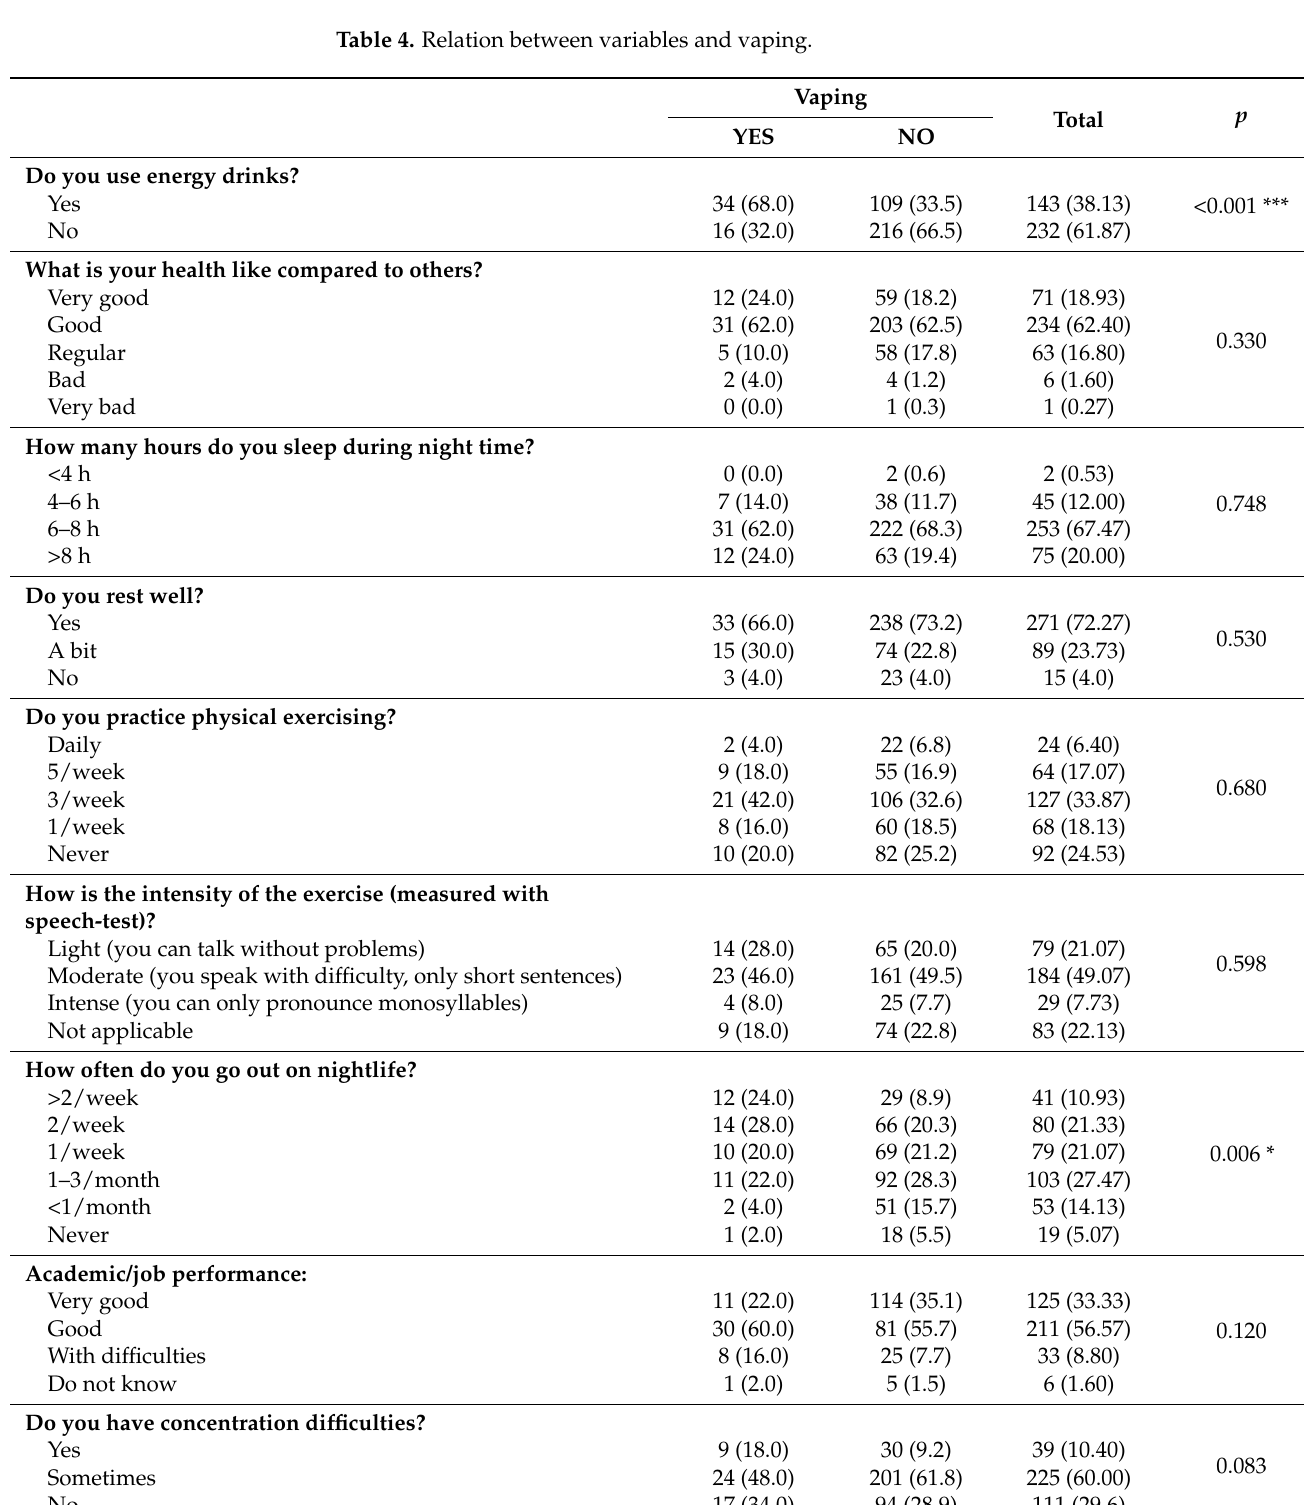
Table 4. Relation between variables and